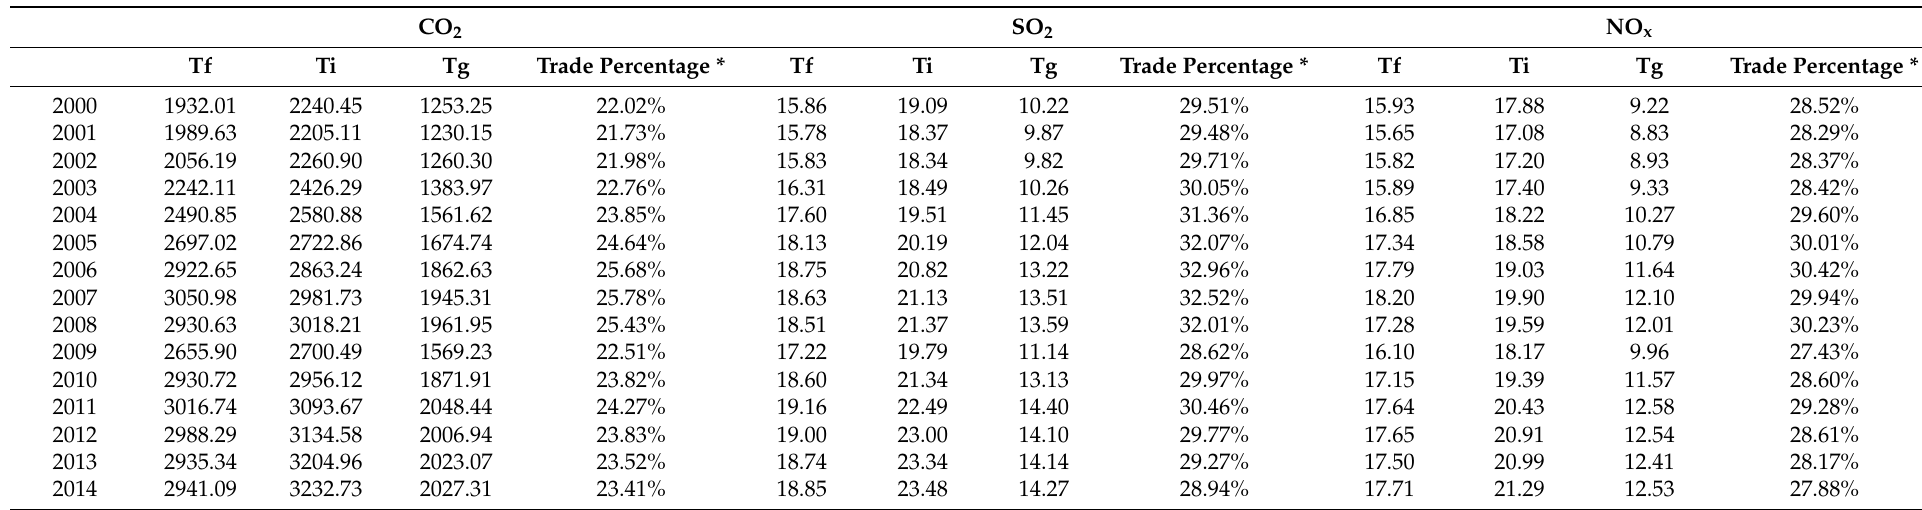
Table A3. Time evolution of emissions under the three trade patterns from 2000 to 2014. (Mt).